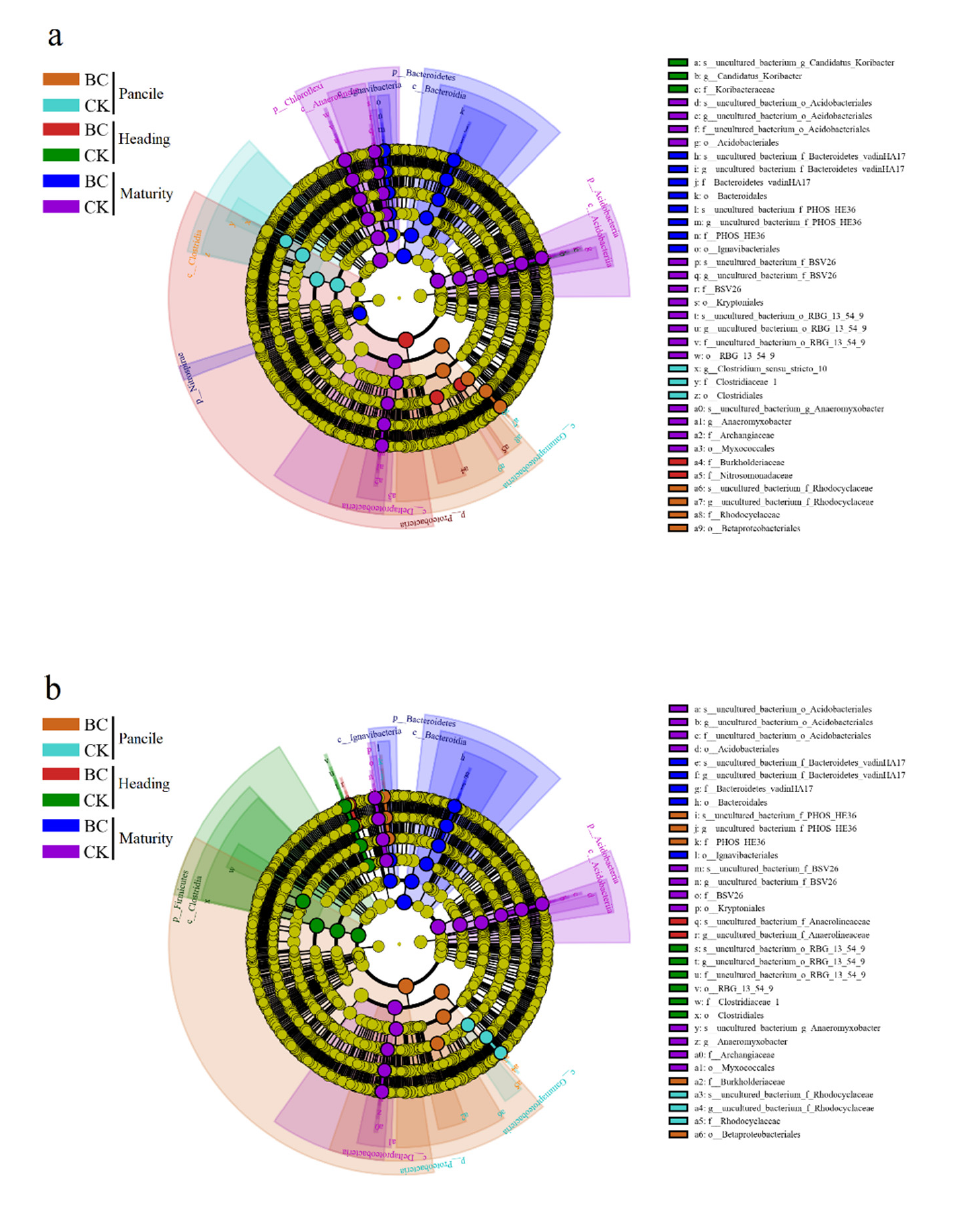
Figure 4. A taxonomic cladogram of Line Discriminant Analysis Effect Size (LEfSe) effect size for a comparison of samples collected from the rhizosphere of ( a ) the varieties of Huanghuazhan and ( b ) the varieties of Meixiangzhan2 in Cd soils. The discriminant taxon nodes are colored and branches are shaded according to the highest-ranked group for that taxon. The yellow nodes represent the microbial groups that did not play an important role in different groups, and no condition was found here (LDA > 4). If a taxon does not represent significant differences among sample groups, the corresponding node is yellow. The selected highly abundant taxa are indicated with letters.